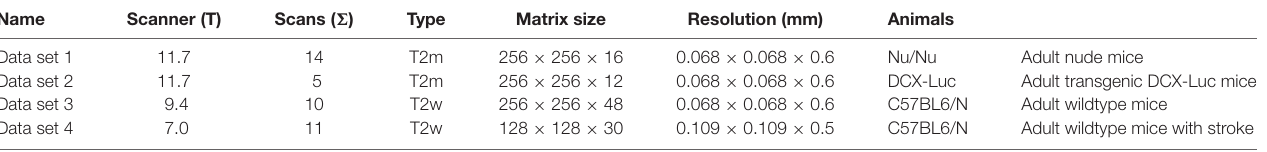
TABLE 2 | Data overview of N T = 40 data used to validate the